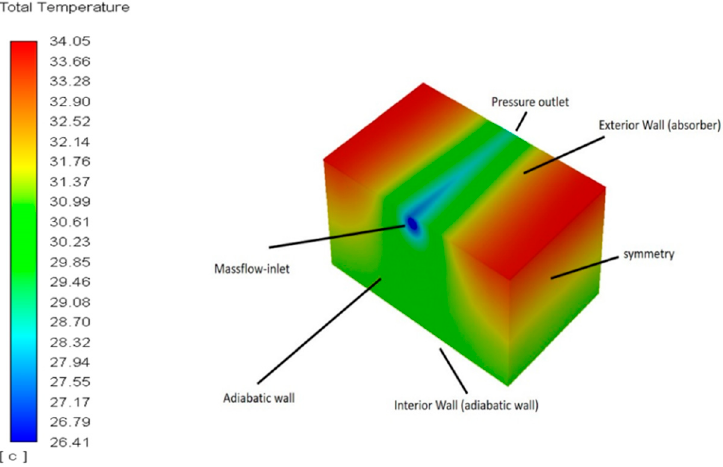
Figure 4. Three-dimensional-Computer Fluid Dynamic (3D)-CFD model, with the boundary conditions representing the computational domain of the solar panel.